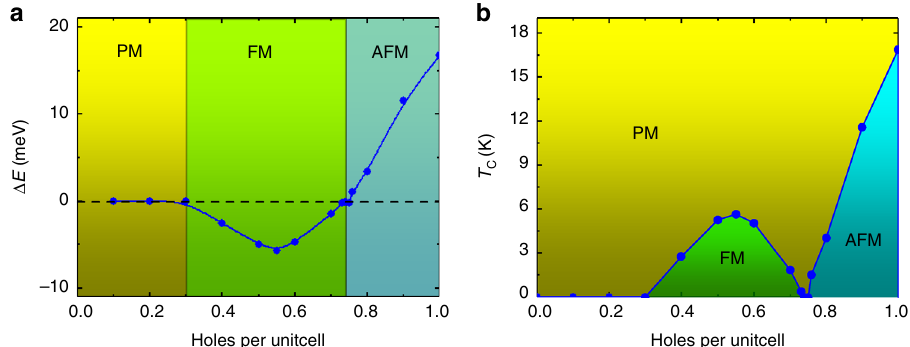
(cid:2) E ð Þ as a function of n FM AFM